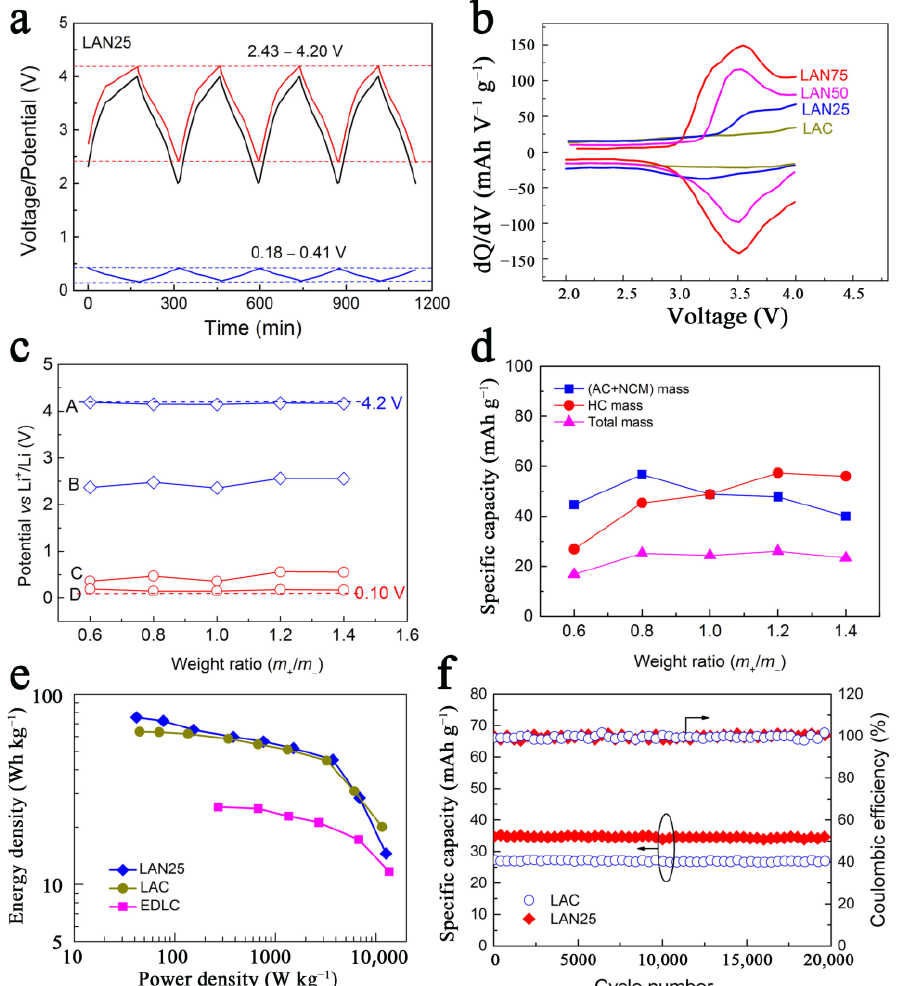
Figure 8. (NCM523+AC)//pre-lithiated HC LIBCs: ( a ) Cell voltage and electrode potential profiles; ( b ) differential capacity versus potential profiles; ( c ) potential versus mass ratio profiles: (A) the maximum and (B) the minimum potentials of cathode, and (C) the maximum and (D) the minimum potentials of anode; ( d ) specific capacity versus mass ratio profiles; ( e ) Ragone plot; ( f ) Cycle performance [56].